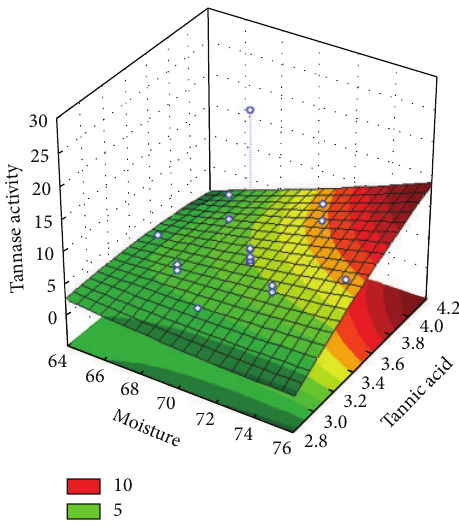
Figure 2: Response surface graph showing the effect of tannic acid and moisture interaction on tannase activity in